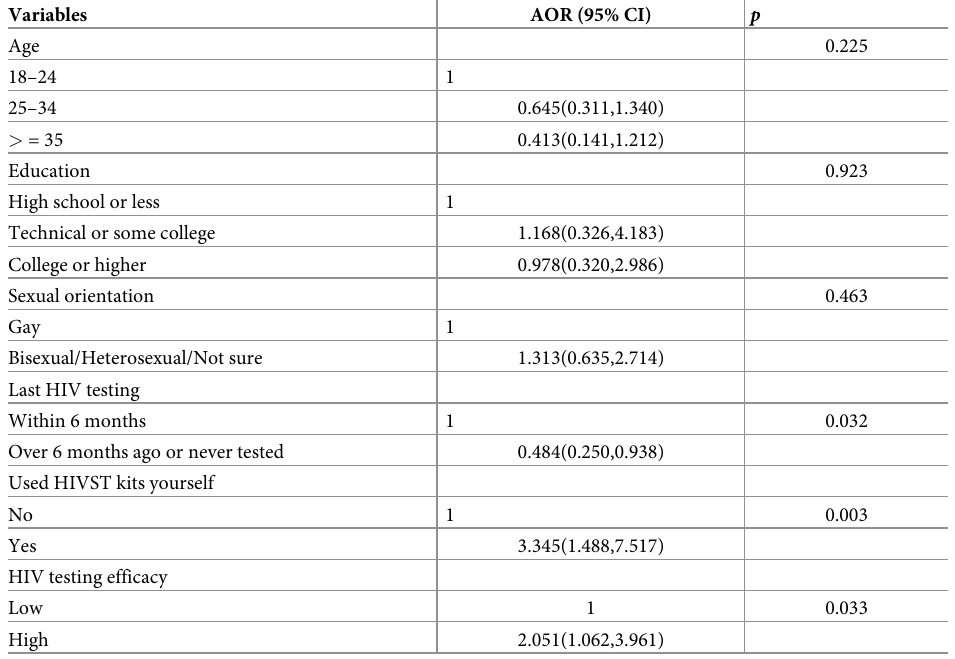
Table 3. Multivariable correlates of distributing HIV self-testing (HIVST) kits to sexual partners among men who have sex with men in Nanjing, China 2017 (N =